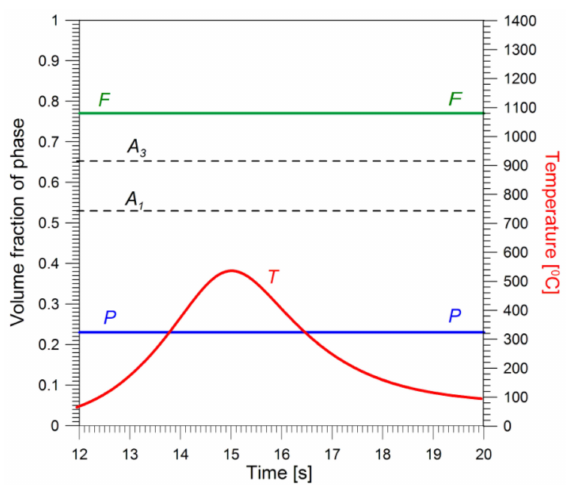
Figure 15. Thermal history at point 4: T —temperature; F , P —volume fractions of ferrite and pearlite.